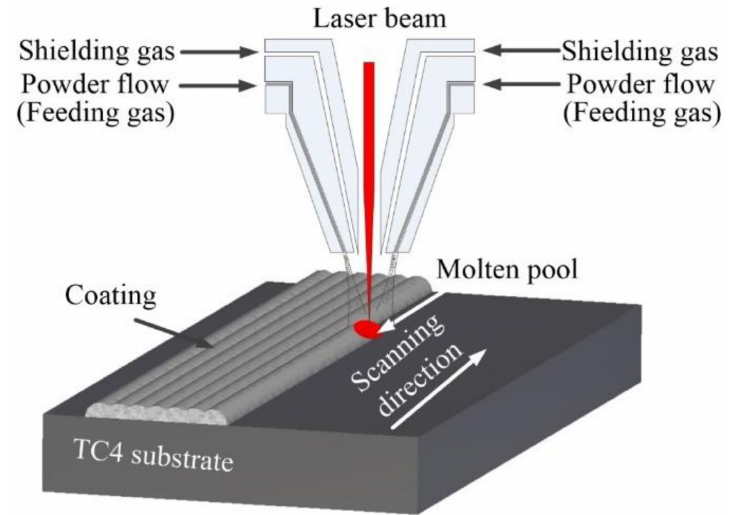
Figure 2. A schematic diagram of the laser-cladding